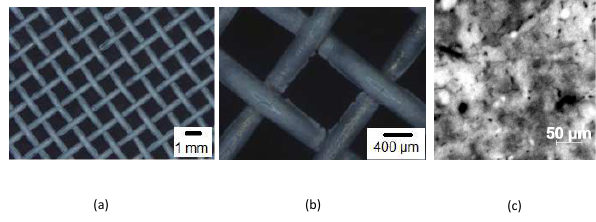
Figure 7. Microscopic image of the stainless steel woven mesh coated with EPD method using O-500 sol gel modified with TiO 2 suspension: (a) low magnification; (b) high magnification; (c) mi- croscopic image of coating film with O500-P25 sol gel by EPD us- ing DC current (6V, 2.5A) during 1min deposition